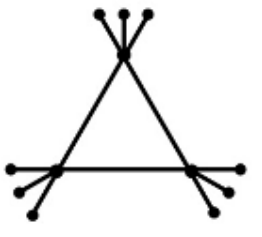
Figure 2: Unicyclic C 3